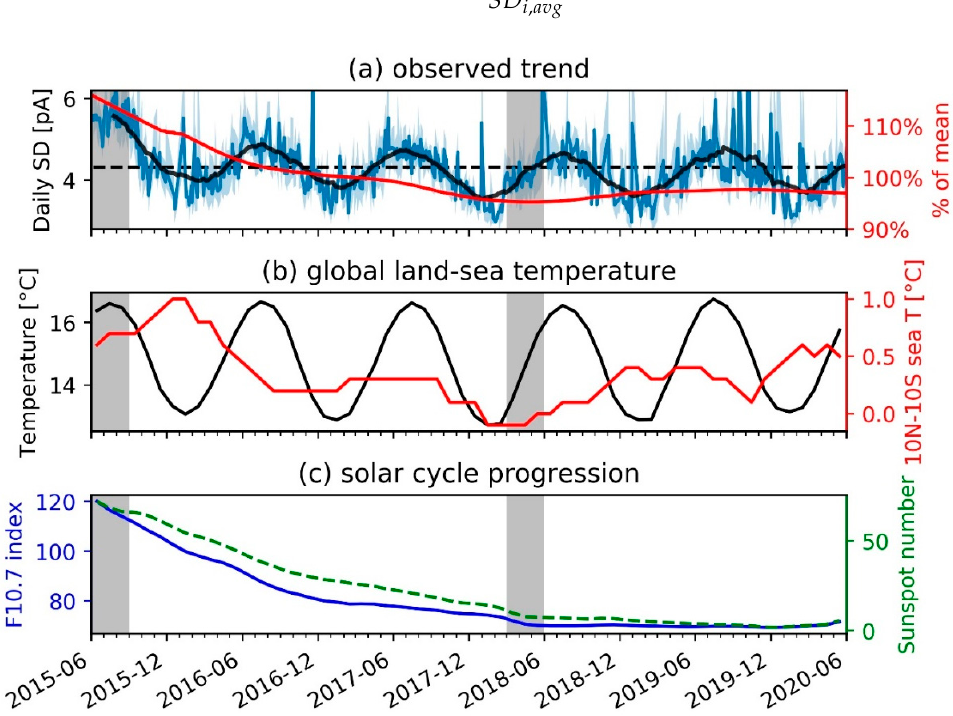
Figure 8. Long-term variations of the 10-45 Hz SD from Jun 2015 to May 2020. ( a ) Daily SD median (solid blue) and rolling mean smoothed curve (solid black), superimposed to the observed trend derived from seasonal decomposition. ( b ) NOAA’s combined global land-sea temperature and 10N-10S SST anomaly. ( c ) Monthly sunspot number and intensity of solar radiation at 10.7 cm wavelength, used as a proxy of solar activity.